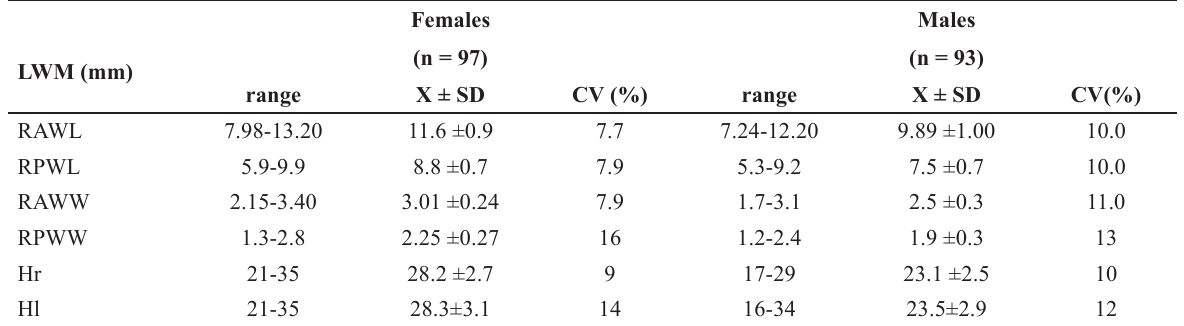
Table 4 . Wing linear measurements (LWM) in adult females and males of P. denticulatum . Range, average (X), standard deviation (SD) and coefficient of variation (CV) for seven wing features: right anterior wing length (RAWL), right posterior wing lenght (RPWL), right